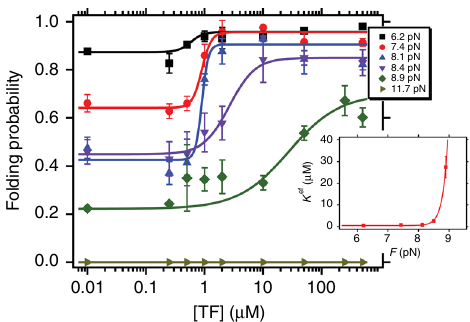
Fig. 3 Titration curve describing the force-dependent effect of the trigger factor concentration on the folding probability of protein L. We monitor the change in the folding probability of protein L at increasing TF concentration for different forces. The sigmoidal dependence of the folding probability with the TF concentration reveals the cooperative effect of TF on protein L under force. Inset shows the half maximal concentration K eff 1/2 , showing a strong non-linear dependence of the TF effective af fi nity with the force. Data points are calculated as described above, using > 3000 s, and over more than three molecules per force. Error s bars are